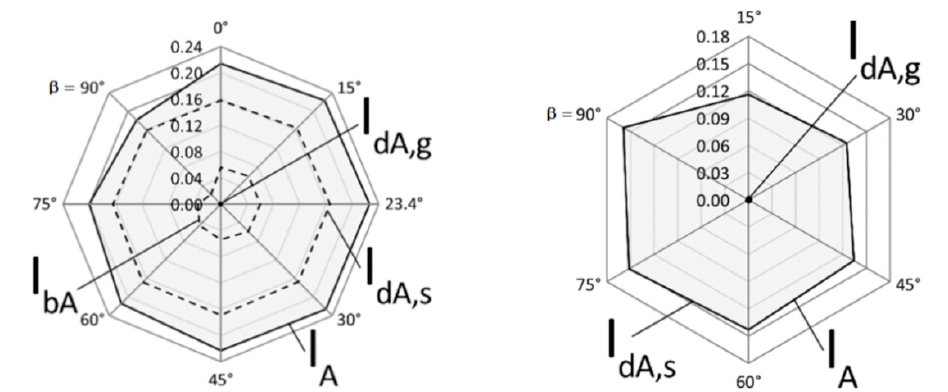
Figure 3. Comparison of the Erythemal UV irradiances received by sloped surfaces facing south (on the left ) and north (on the right ).